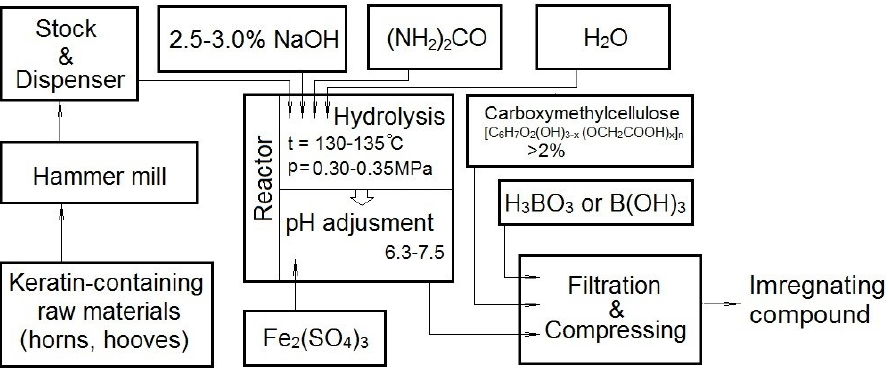
Figure 1. Impregnation compound production technology.